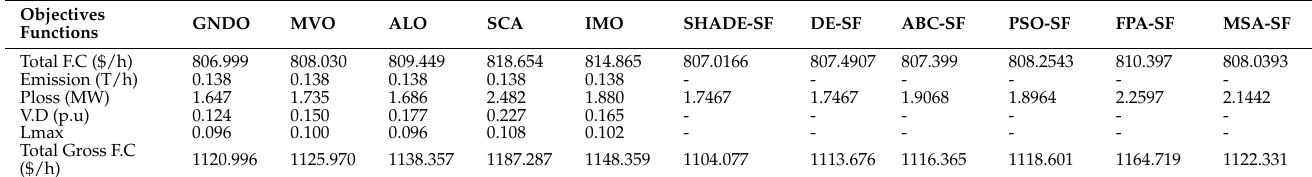
Figure 17. Comparison of the TFC reduction ($/h) with other algorithms.